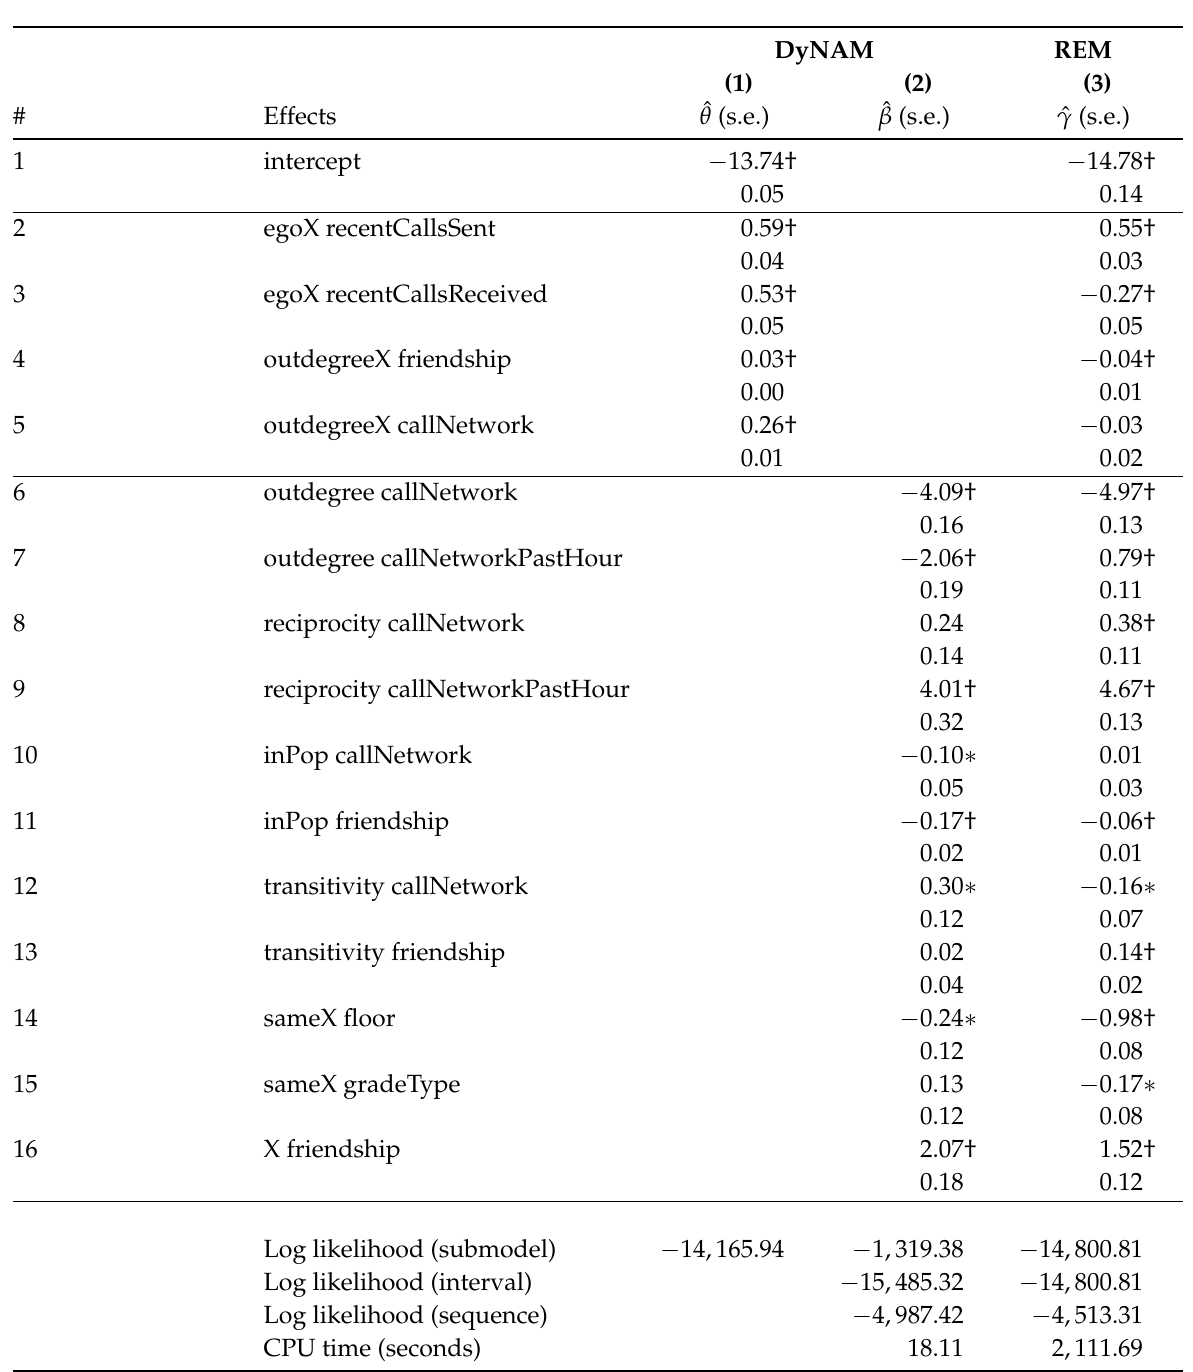
Table 1: Results of the case study using DyNAM and